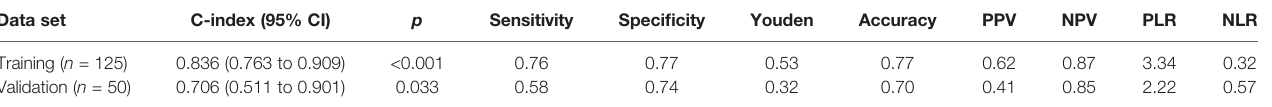
TABLE 5 | C-index and diagnostic index of fi nal model in both